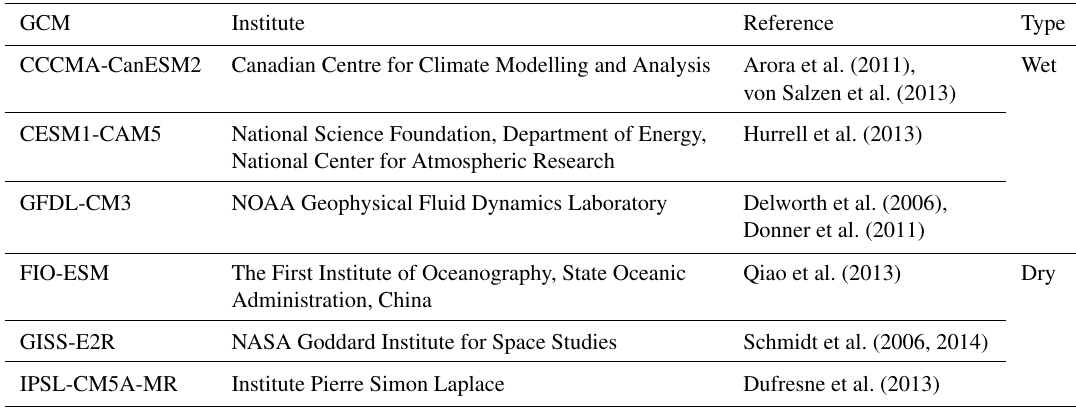
Table 1. Inventory of global climate models (GCMs) used in the current study.